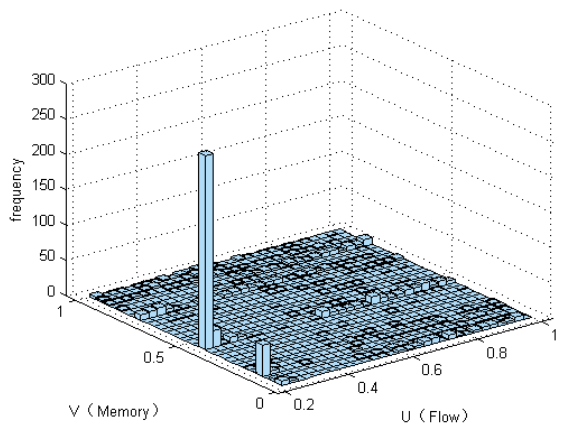
Figure 8. Density function of memory.